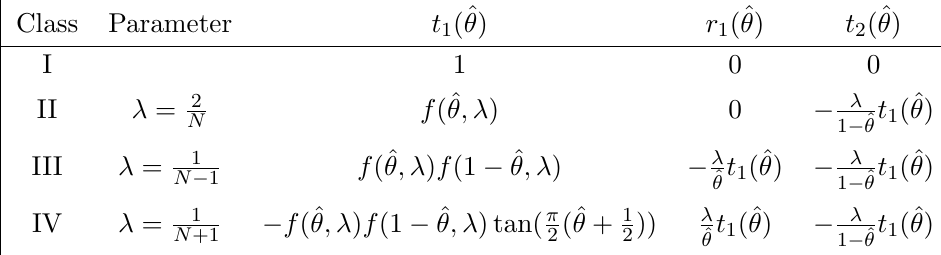
Table 1 . Classes I-IV of U( N ) minimal solutions.